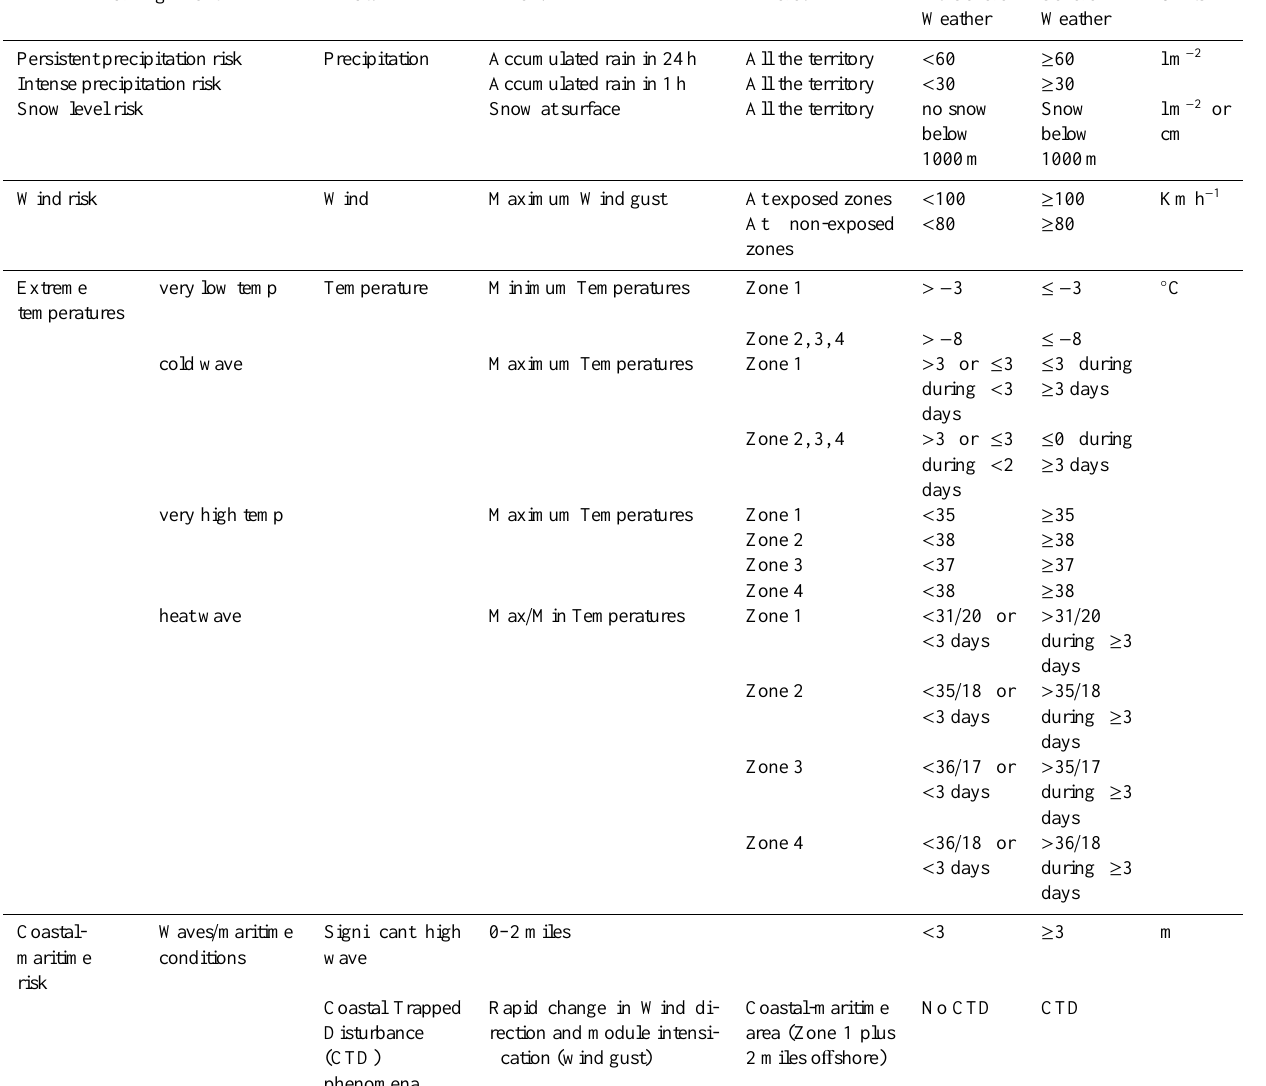
Table 3. Event threshold classification for former Euskalmet warning